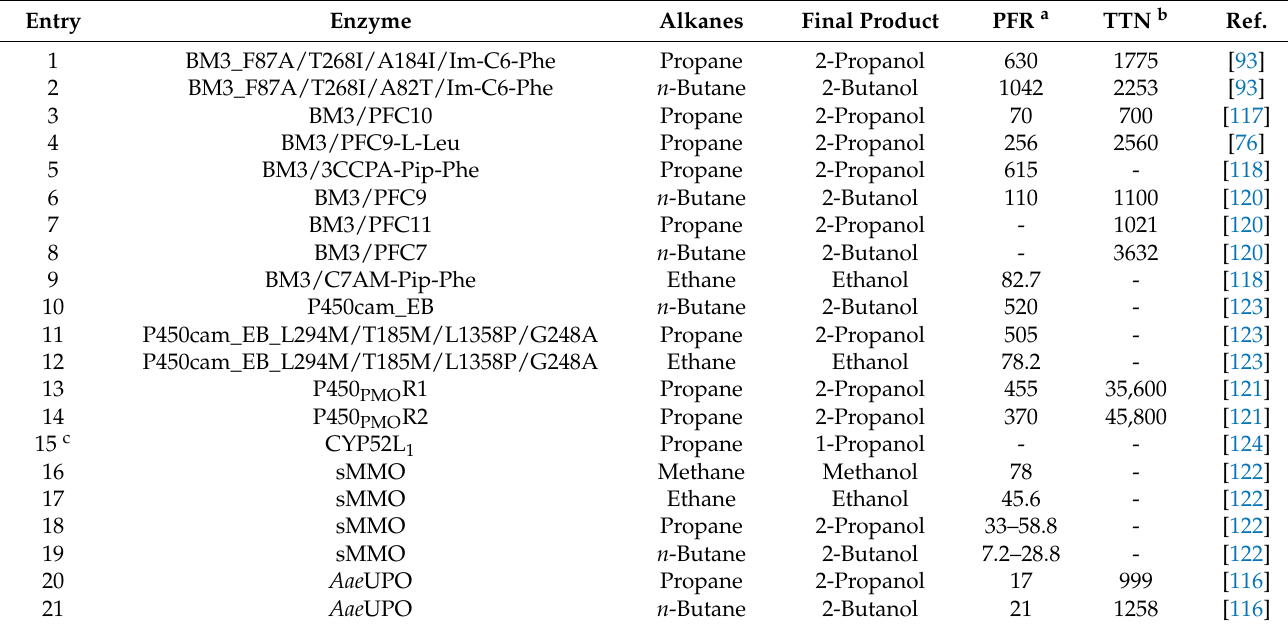
Table 1. Catalytic hydroxylation of small alkanes by various enzymes in